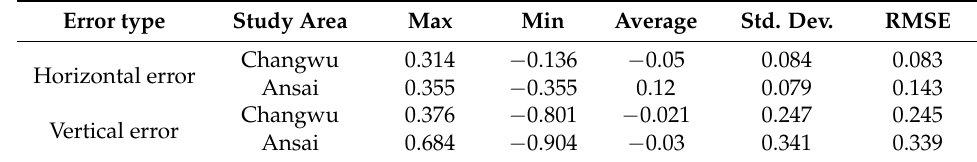
Figure 7. Boxplots of error measured between independent control points and the generated DEM (Vertical) and ortho-mosaics (Horizontal). Table 3. Statistics of the vertical error and horizontal error (all values in m).